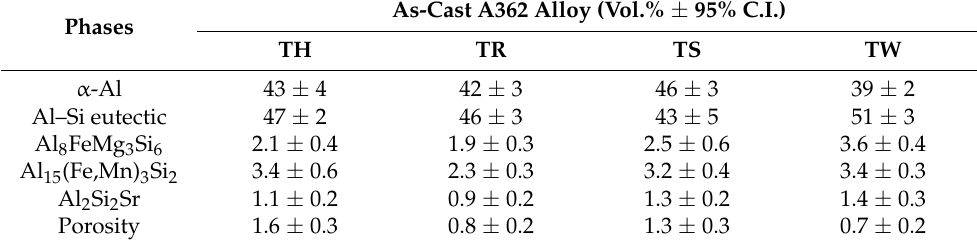
Figure 10. Micrograph showing TW specimen: ( A ) representative primary phases; ( B ) close-up of the red box region in ( A ). Table 5. Summary of the average volume fraction for the porosities and various phases of interest in the T5 heat-treated